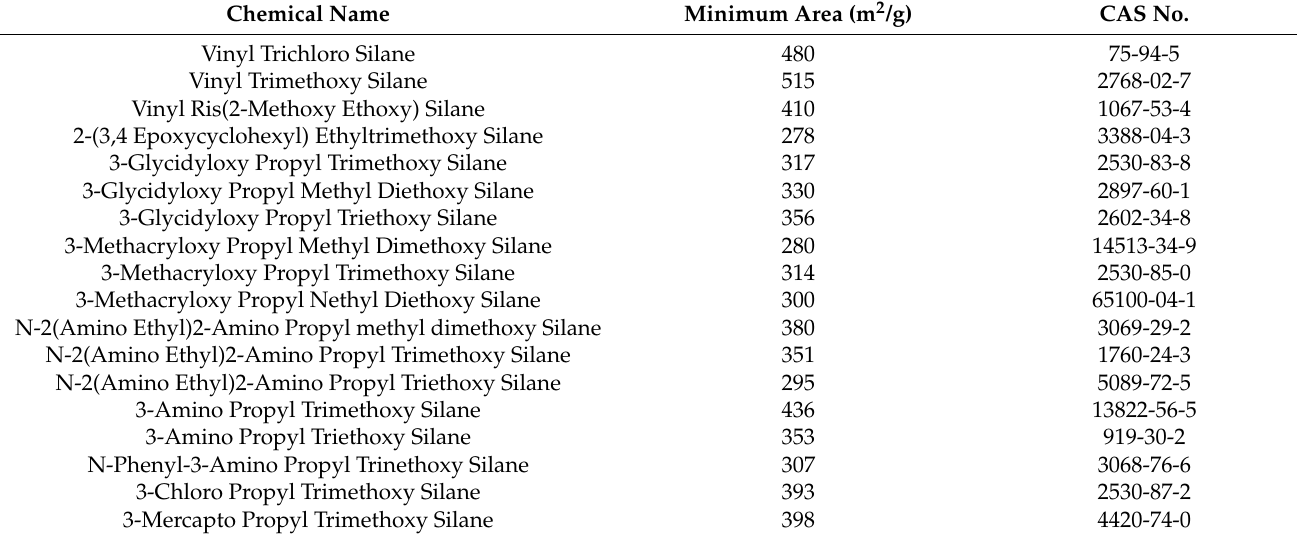
Table 3. Types of silane coupling agents.